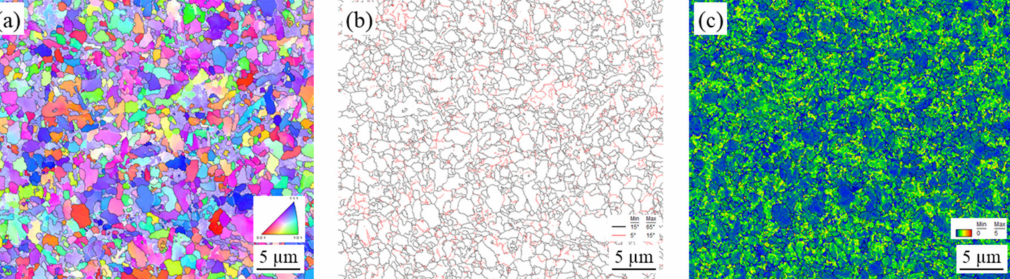
Figure 12. EBSD characterization at the representative FG area near the top surface of sample B: ( a ) inverse pole figure; ( b ) grain boundary; and ( c )